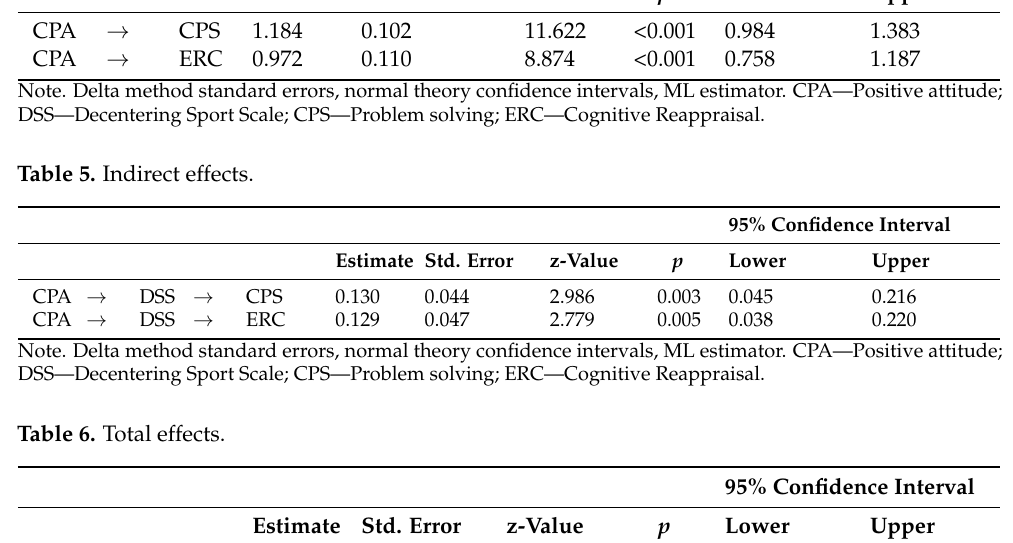
Problem solving; ERC—Cognitive Reappraisal.